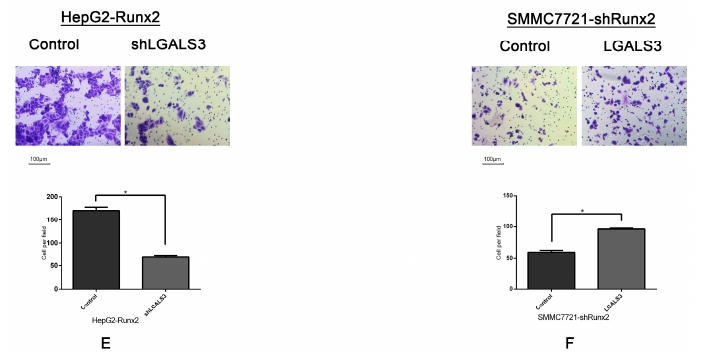
Figure 7. Western blot analysis, β -actin was used as the loading control. ( A ) Protein levels of Galectin-3, Runx2, E-cadherin, Vimentin, and VE-cadherin after LGALS3 knockdown in HepG2-Runx2 cells; ( B ) Transfection of LGALS3 plasmid in SMMC7721-shRunx2 cells; protein levels of Galectin-3, Runx2, E-cadherin, Vimentin, and VE-cadherin. Wound healing assays. ( C ) HepG2-Runx2-control group and the HepG2-Runx2-shLGALS3 group at 0 and 72 h (×40; bars 100